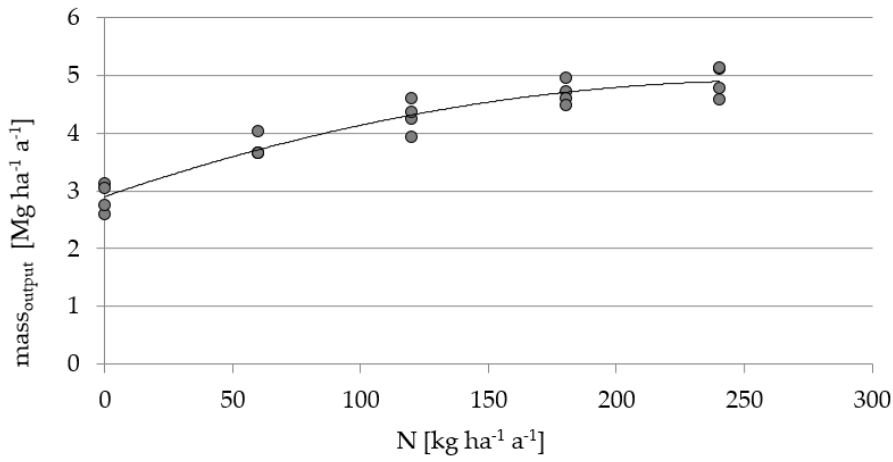
Figure 2. Relationship between crop yield (yield) and fertilizer treatments (N) with quadratic crop yield response function in the experiment (Equation (3)) for the three years.